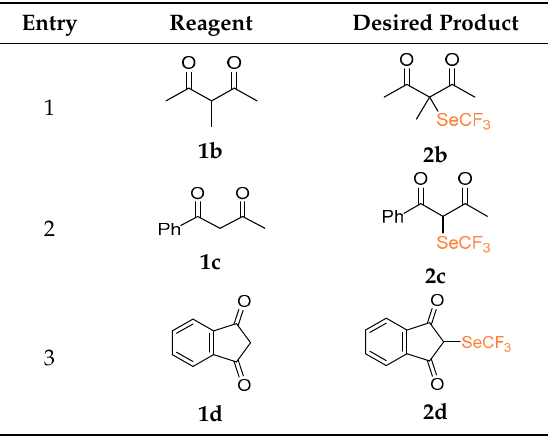
Table 1. α -Trifluoromethylselenolation of diketones.